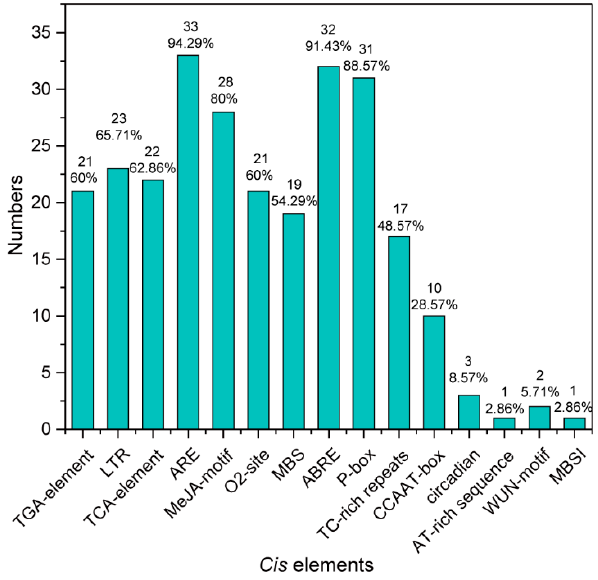
Figure 5. Statistics of different Cis elements in the promoter of the identified 35 TCP genes.